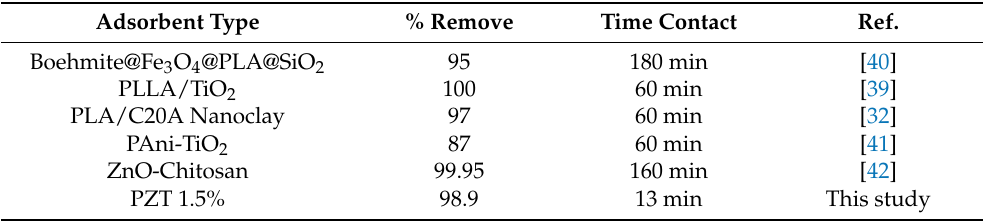
Table 5. A comparison between the performance of the polymeric adsorbents in previous works and nanocomposite PZT in this study for the removal of methylene blue. Adsorbent